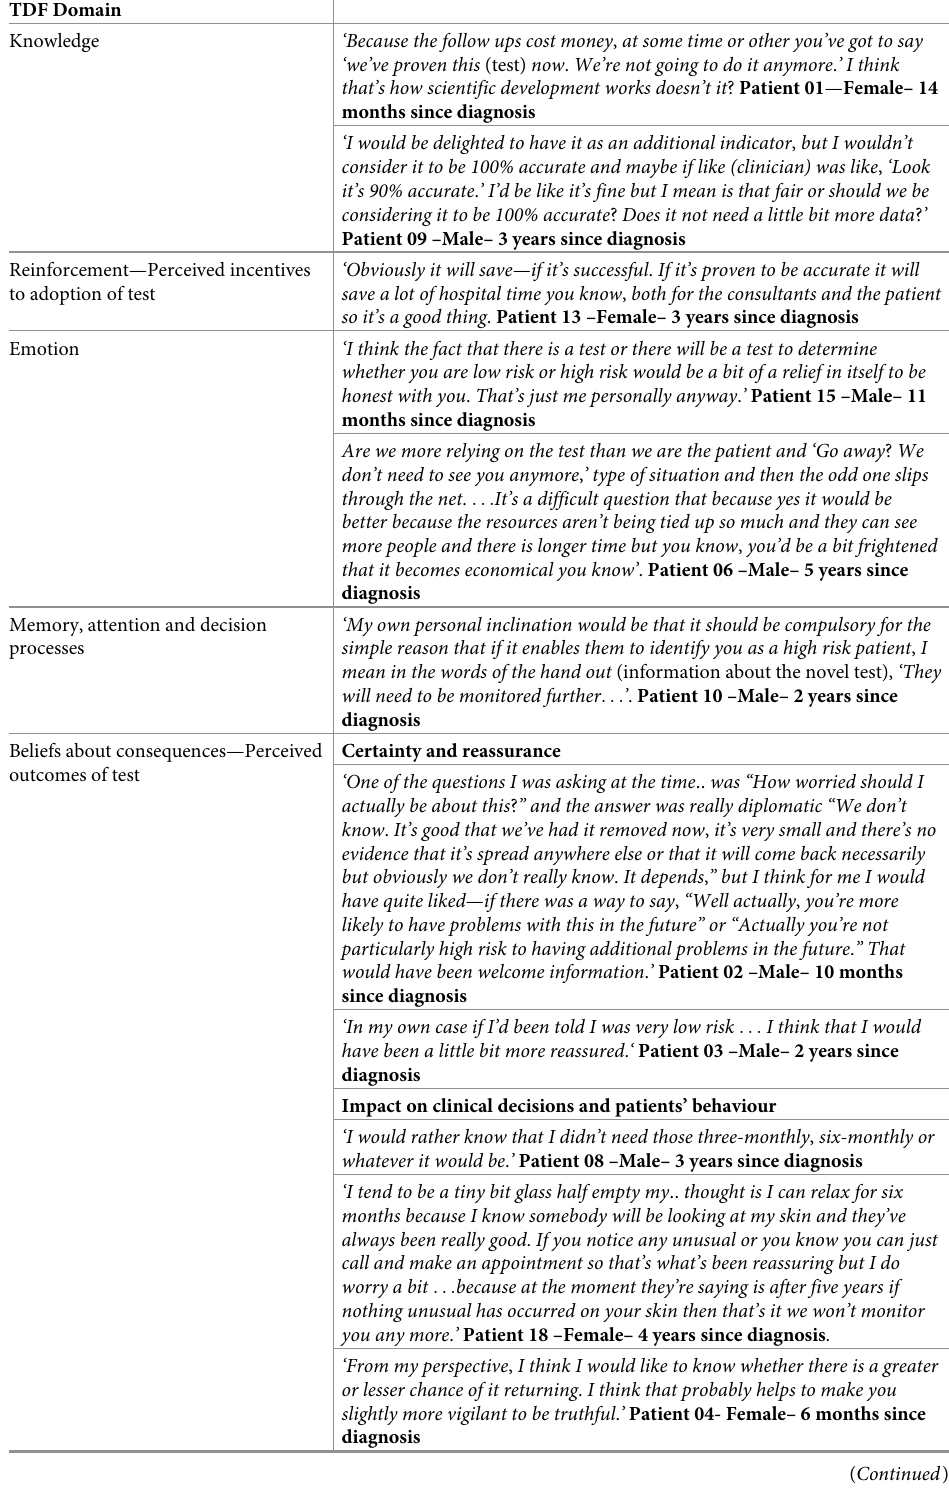
Table 3. Theoretical Domains Framework and illustrative patient